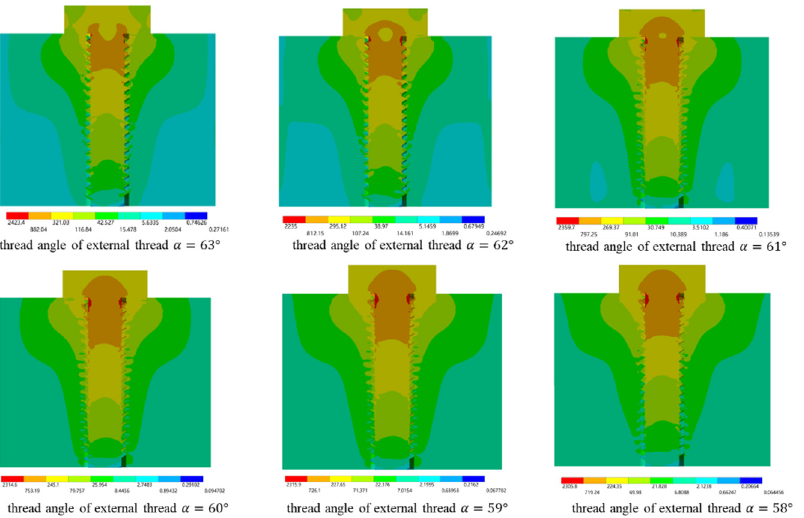
Figure 9. Contact stress distribution under the influence of thread profile angle deviation.